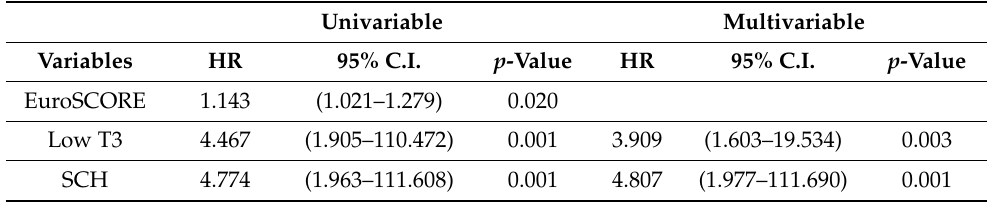
Figure 2. Kaplan–Meier curves for long-term, all-cause mortality (median follow-up of 30 months) with 95% confidence interval. * p < 0.05 versus Euthyroid group. SCH (subclinical hypothyroidism); T3 (triiodothyronine). Table 5. Cox regression analyses of risk factors for long-term mortality.